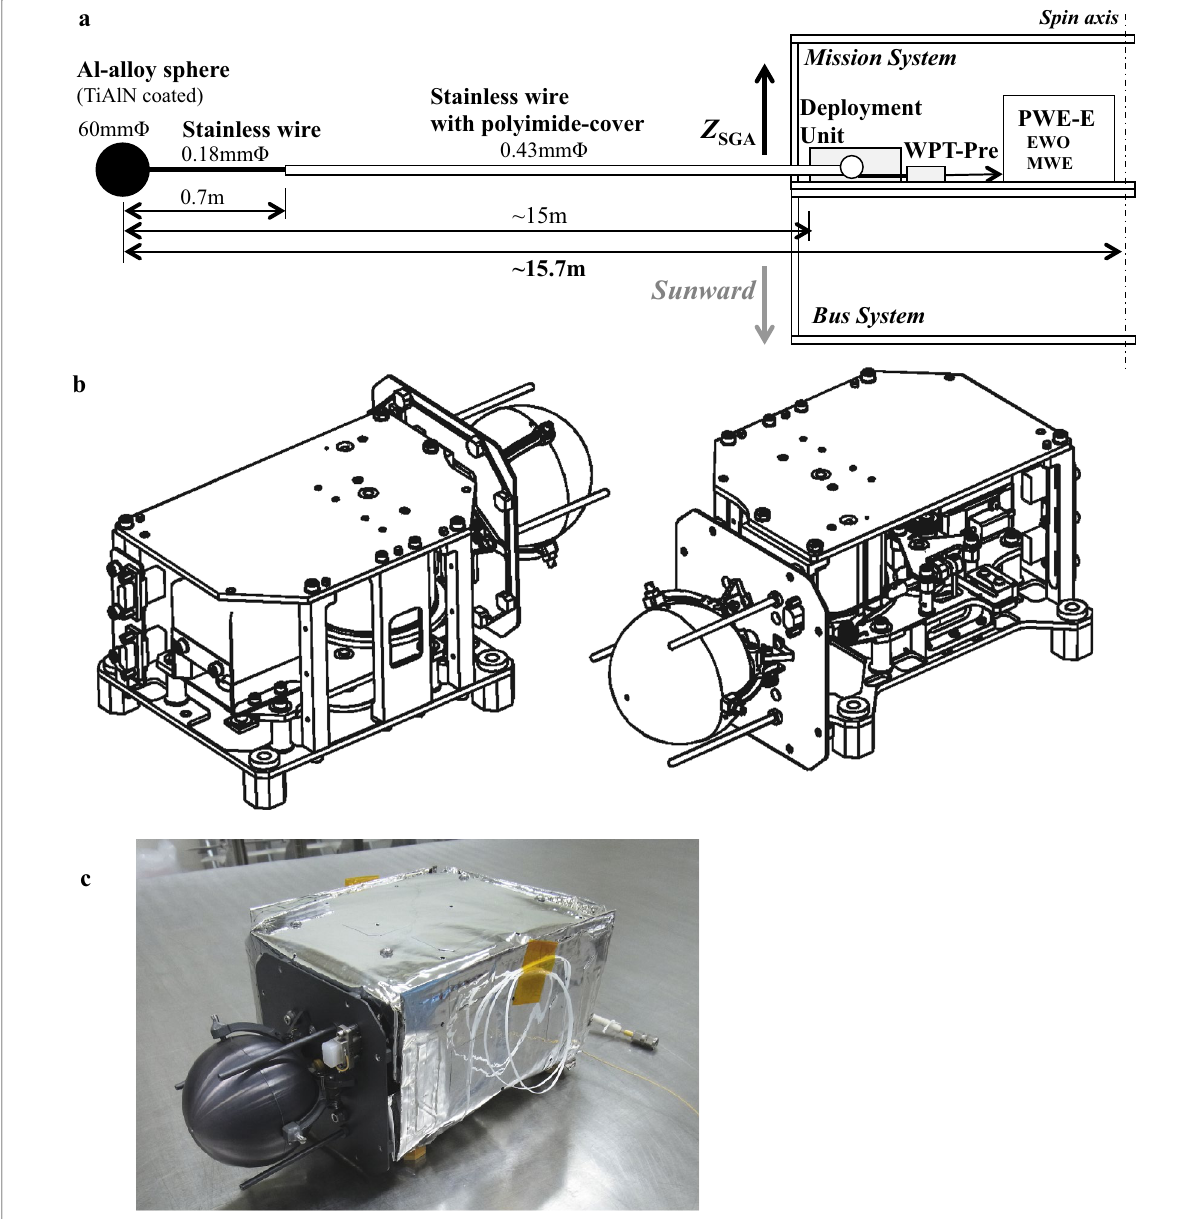
Fig. 3 WPT-S boom. a Geometry, b schematic drawings, and c photograph of the flight model. b and c are obtained from Nippi